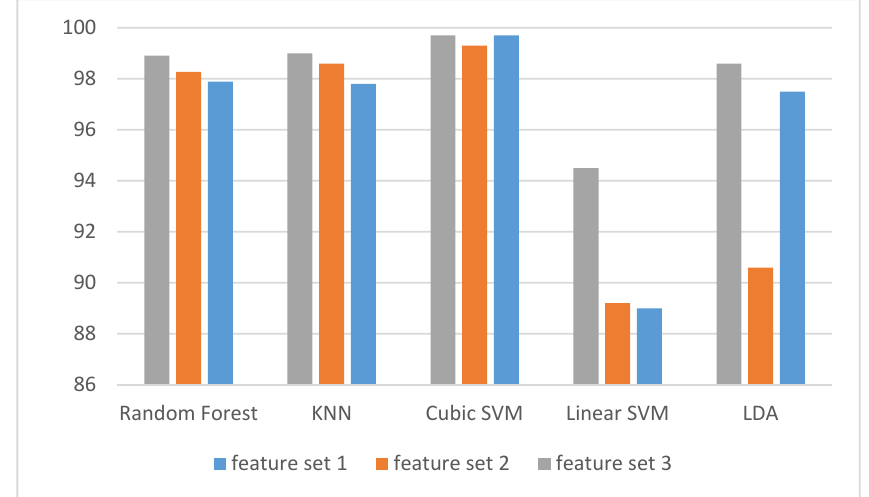
Figure 5. Receiver operating characteristic (ROC) curves for detecting stress and non stress; ( a ) cubic support vector machine (SVM) classifier, ( b ) k -nearest neighbour (KNN) classifer.